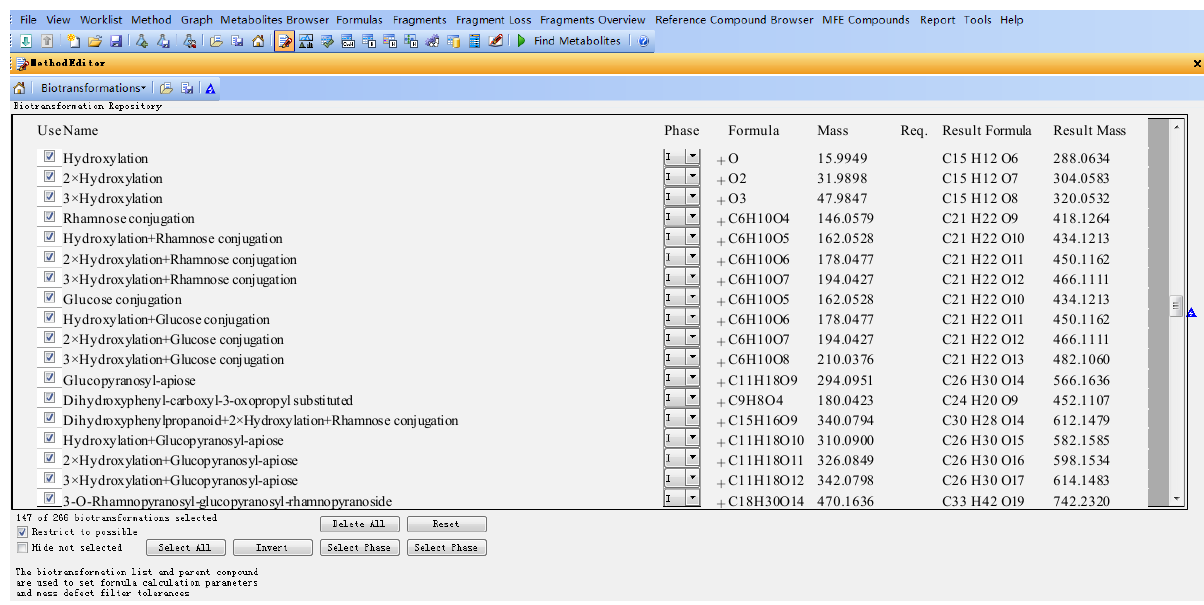
Figure 2. Flavanonol database (parts) established using MassHunter Metabolite ID based on flavonoid metabolic principles.